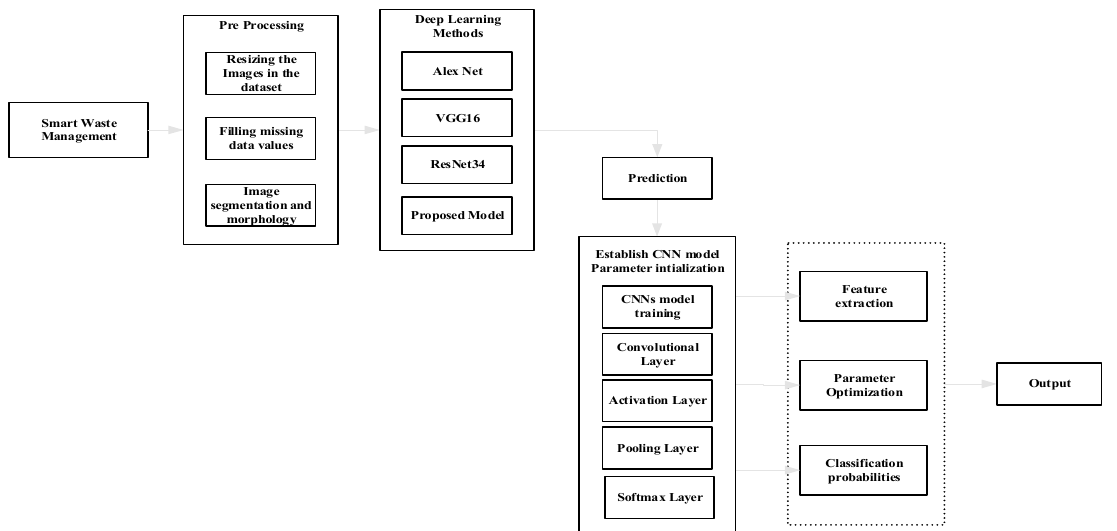
Figure 1. The proposed LADS framework.